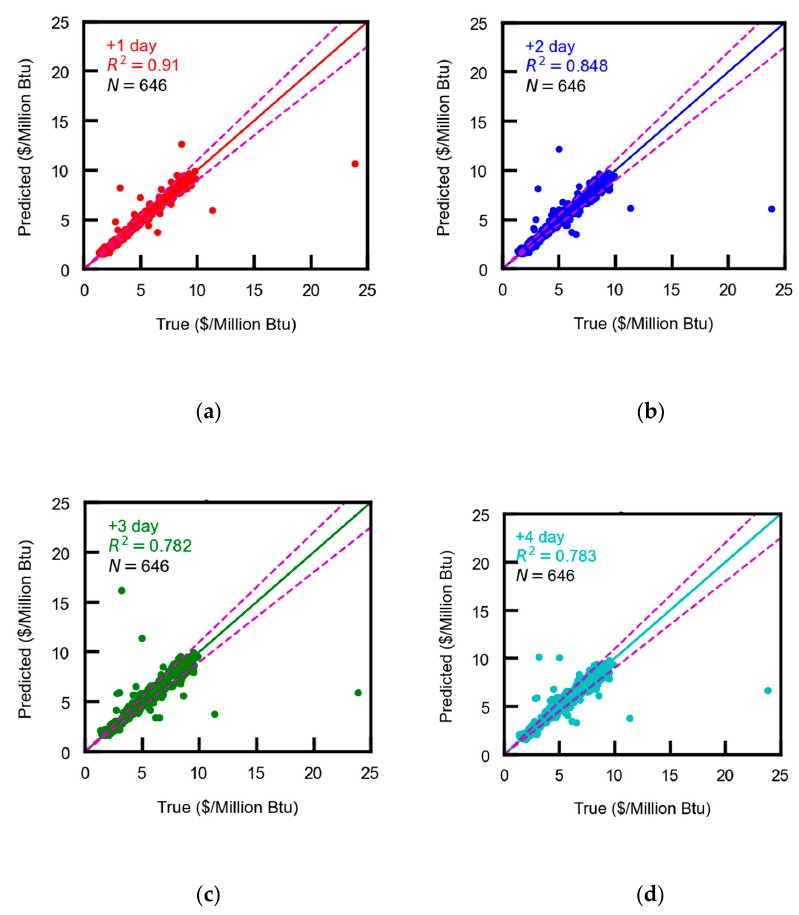
Figure 9. Scatterplot of multi-step prediction of TCN model, ( a ) +1 day, ( b ) +2 day, ( c ) +3 day, ( d ) +4